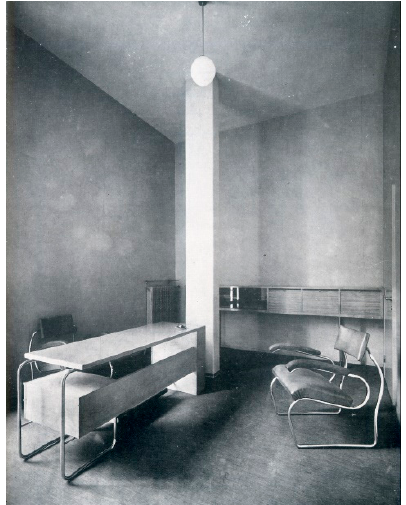
Figure 26. Day care “Sant’Elia” by Giuseppe Terragni. Como (1936–1937). Director's office with the “Benita” model armchair. Photo from (Crespi 1987).